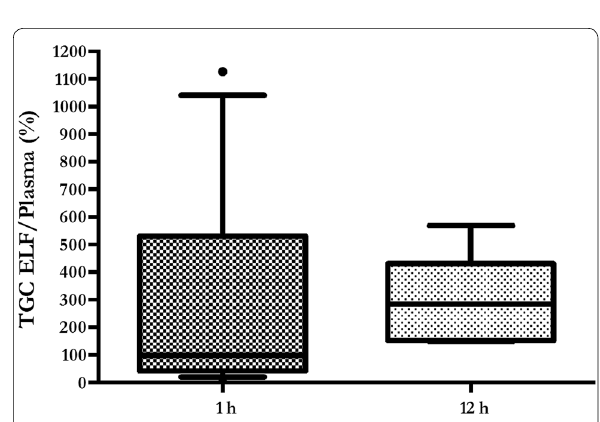
Fig. 4 Boxplot showing tigecycline ELF to plasma ratio (%). Boxes represent interquartile ranges (lower border 25th percentile; upper border 75th percentile), and the horizontal lines within the boxes indicate the medians (50th percentile). Whiskers indicate minimum and maximum